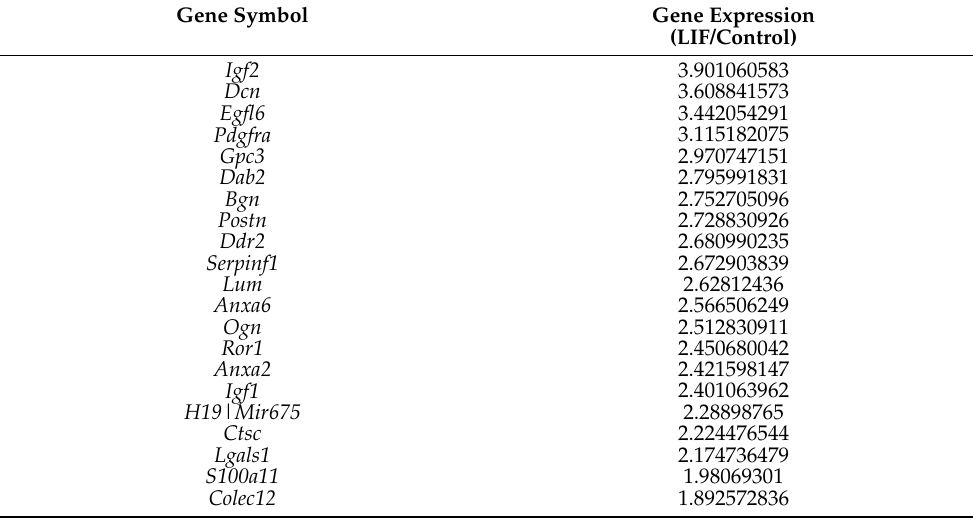
Table 1. Extracted differentially expressed 21 genes with fold change (FC) > 1.5 from the dataset of DNA microarray analysis screened by Pairwise scatter